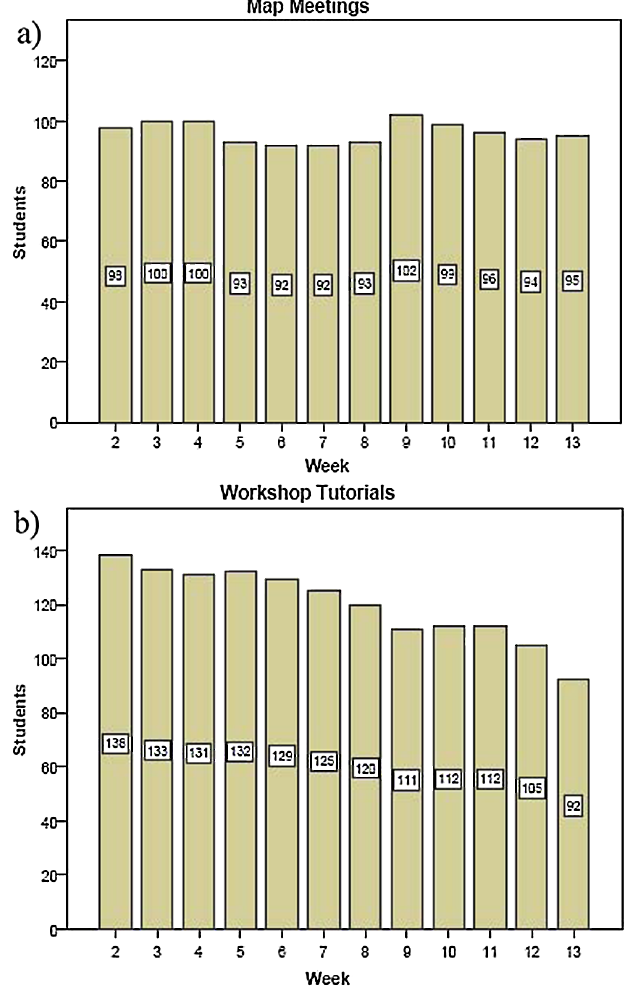
FIG. 3 (color online). Weekly attendance at Map Meetings (a) and Workshop Tutorials (b) in first semester. Tutorials start in week